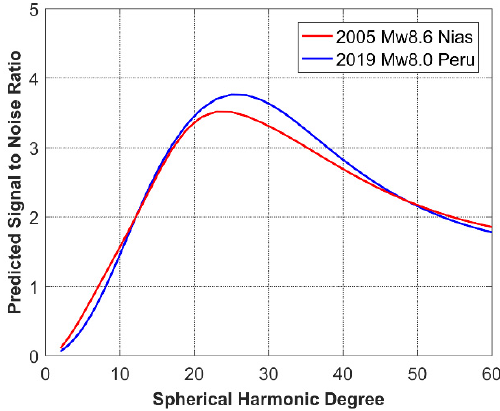
Figure 14. Ratio of the coseismic gravity changes to cumulative error of stacking method in spectral domain. The blue line is the ratio of the coseismic signal of the 2019 Mw8.0 Peru earthquake to the error of the GFO stacking method. The red line is SNR of the 2005 Mw8.6 Nias event for the GRACE error.